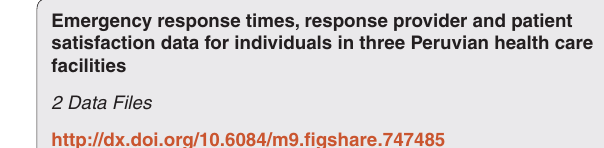
* Provinces: Ayacucho y Pucallpa. ** Model 1 adjusted for age and sex. ¶ Model 2 adjusted for age, sex, education, employment, type of establishment, caregiver that provided care in the facility, time from the event to facility, and explanation of diagnosis to the patient.